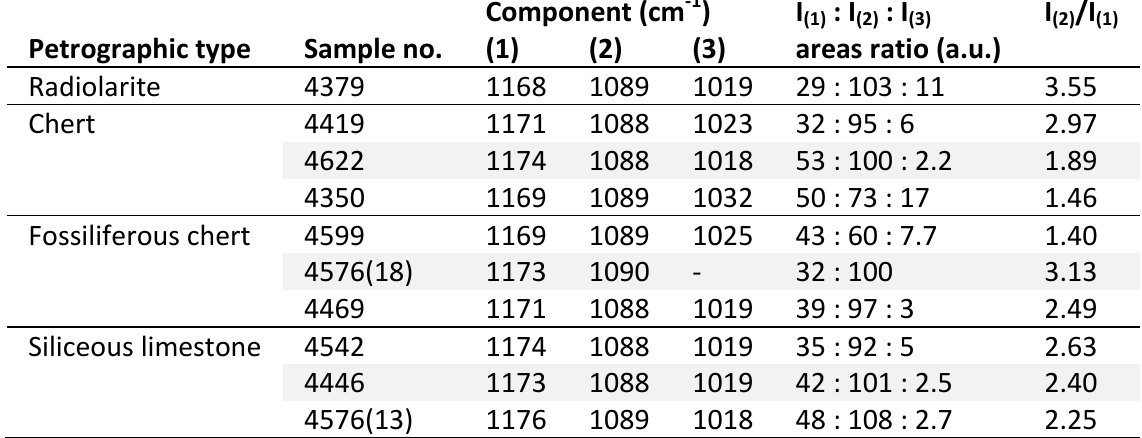
Table 2. The wavenumbers for the component signals of deconvoluted spectra and the ratio between the intensity (I) of each